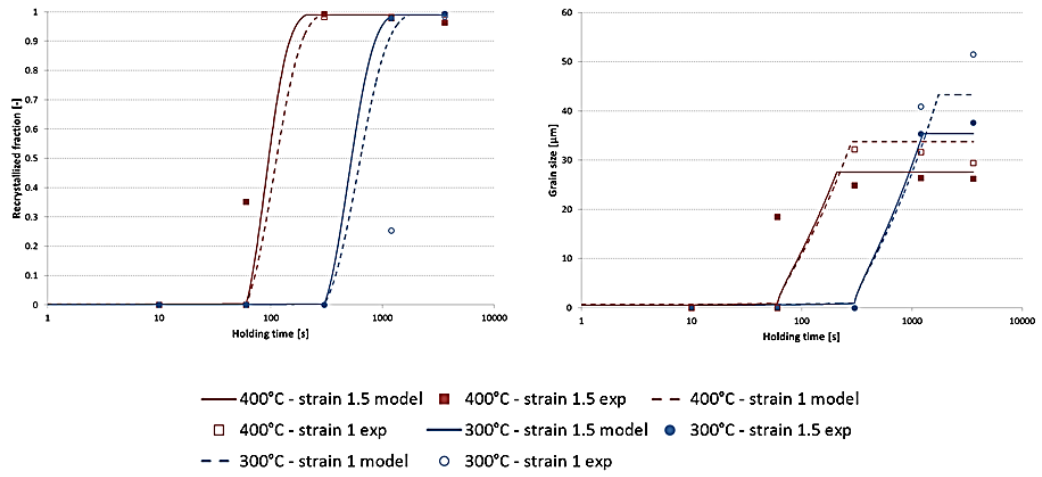
Figure 9. Recrystallised fraction ( left ) and grain size ( right ) during annealing following cold deformation at two different strains.